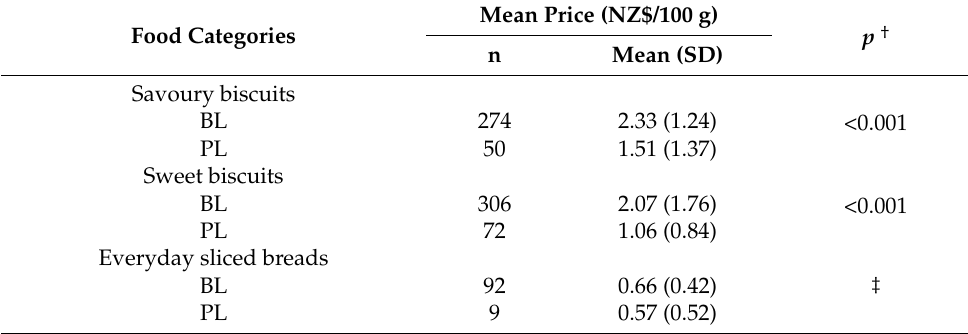
Table 4. Mean (SD) price (in New Zealand dollars) between branded label and private label products by food category and overall,